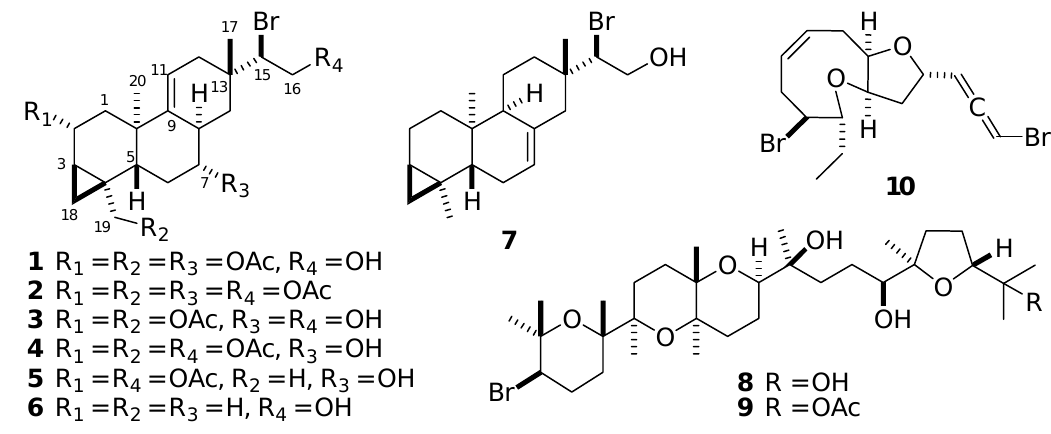
Figure 1. Structures of compounds 1 - 10